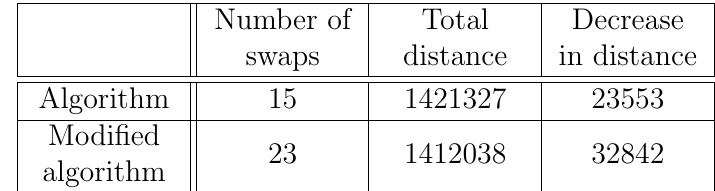
Table 2: Comparison of the algorithms with the US Airport data set